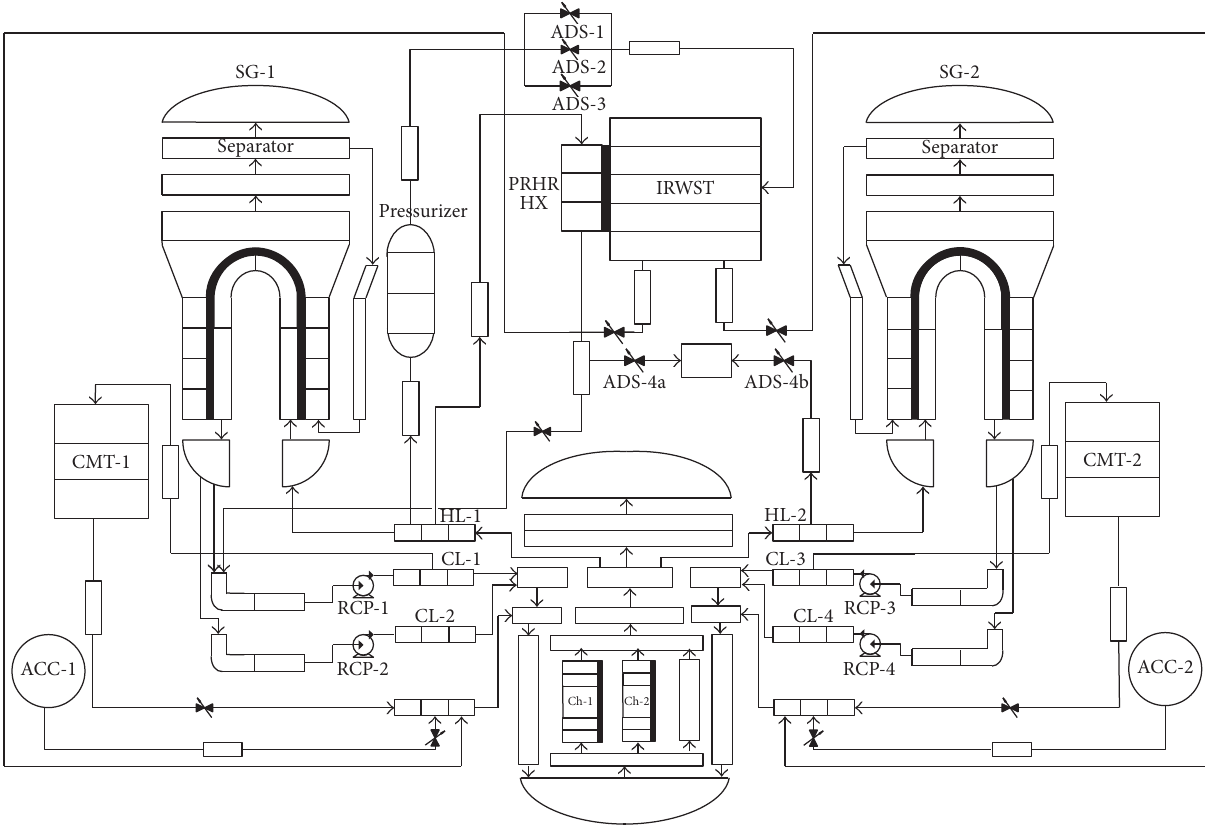
Figure 2: RELAP5 model for